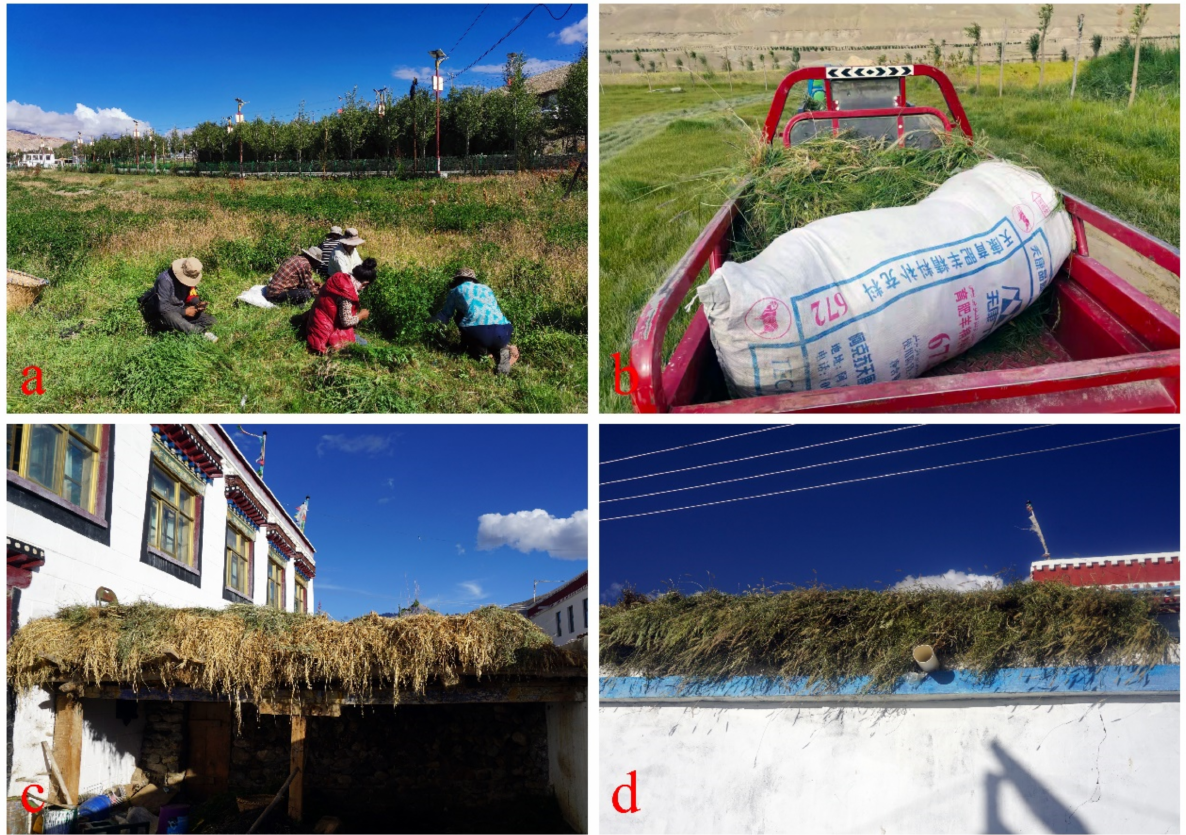
Figure 6. The process of fodder gathering. ( a ): Harvesting fodder; ( b ): shipping fodder; ( c , d ): drying